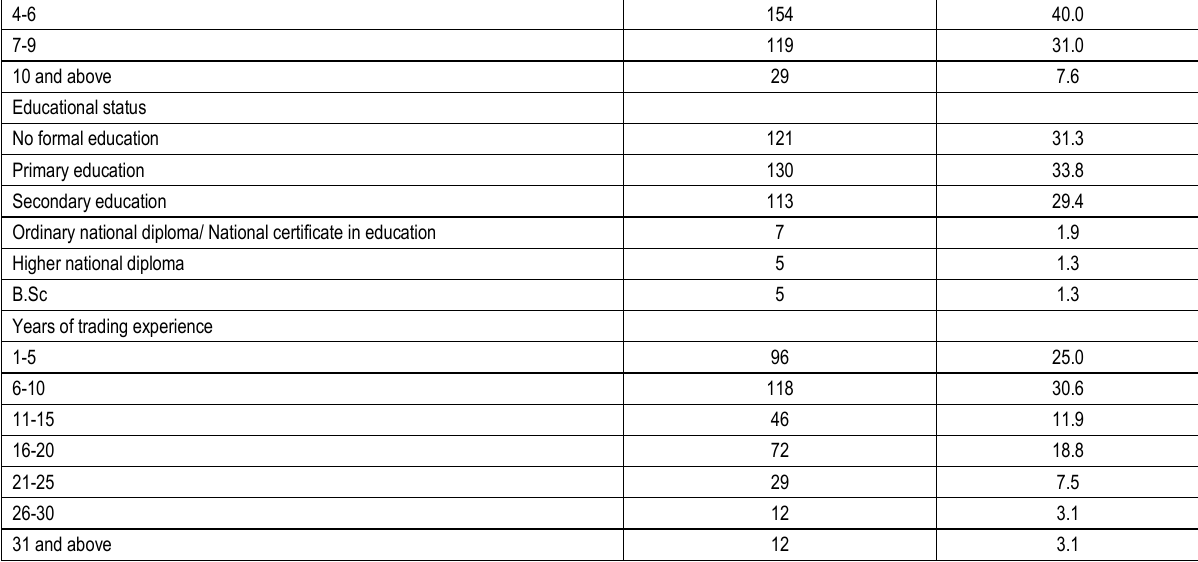
Table 2. (cont.) Socioeconomic characteristics of respondents